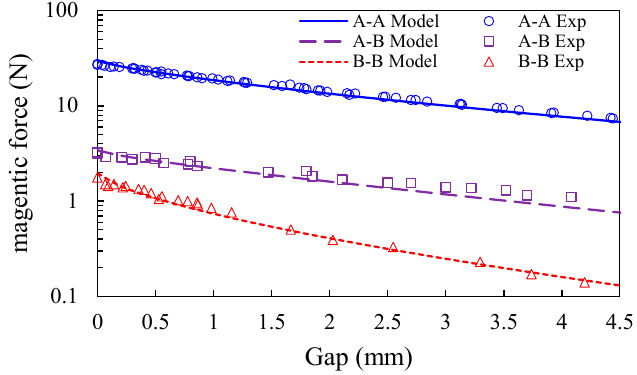
Figure 7. The comparisons of magnetic forces by measurements and model for magnet pairs A-A, B-B, and A-B for various gaps.